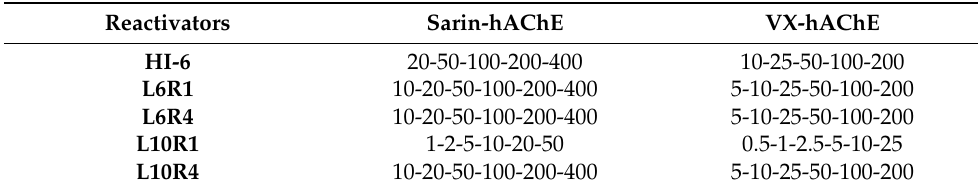
Table 3. Reactivator concentrations ( µ M) used for determination of the observed first-order rate constant k obs